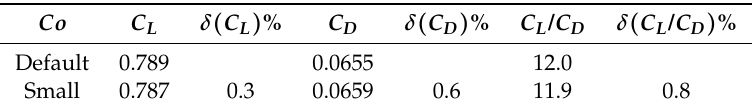
Sensitivity study on Courant number threshold for Re = 10 4 and AoA = 4 ◦ . Default corresponds to Co < 2, small corresponds to Co < 1. δ is the relative difference with the default Courant number threshold